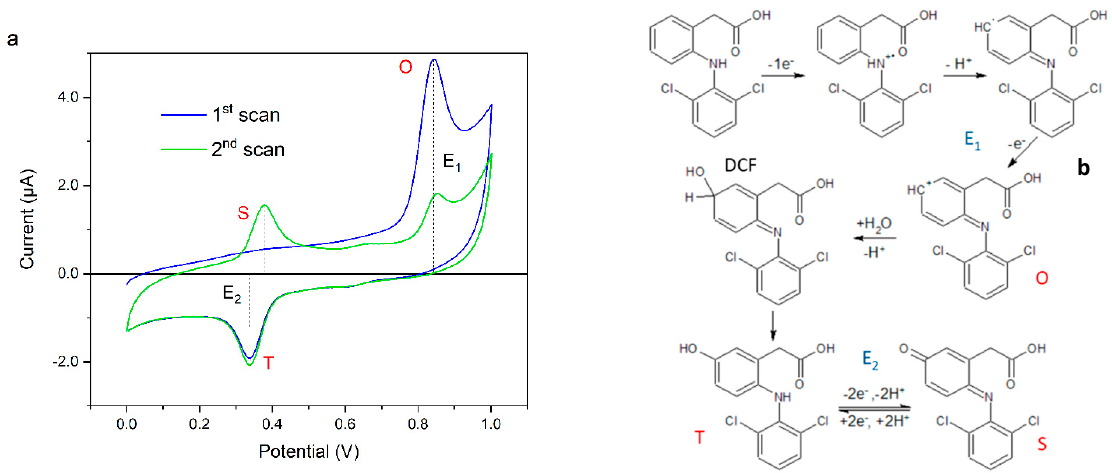
Figure 2. ( a ) Consecutives CV scans (aGCE) of 20 µg L − 1 DCF in 1 × 10 − 2 mol L − 1 phosphoric buffer, pH = 2.0; ( b ) Redox electrochemical-chemical (E1C1E2) mechanism of DCF [8].